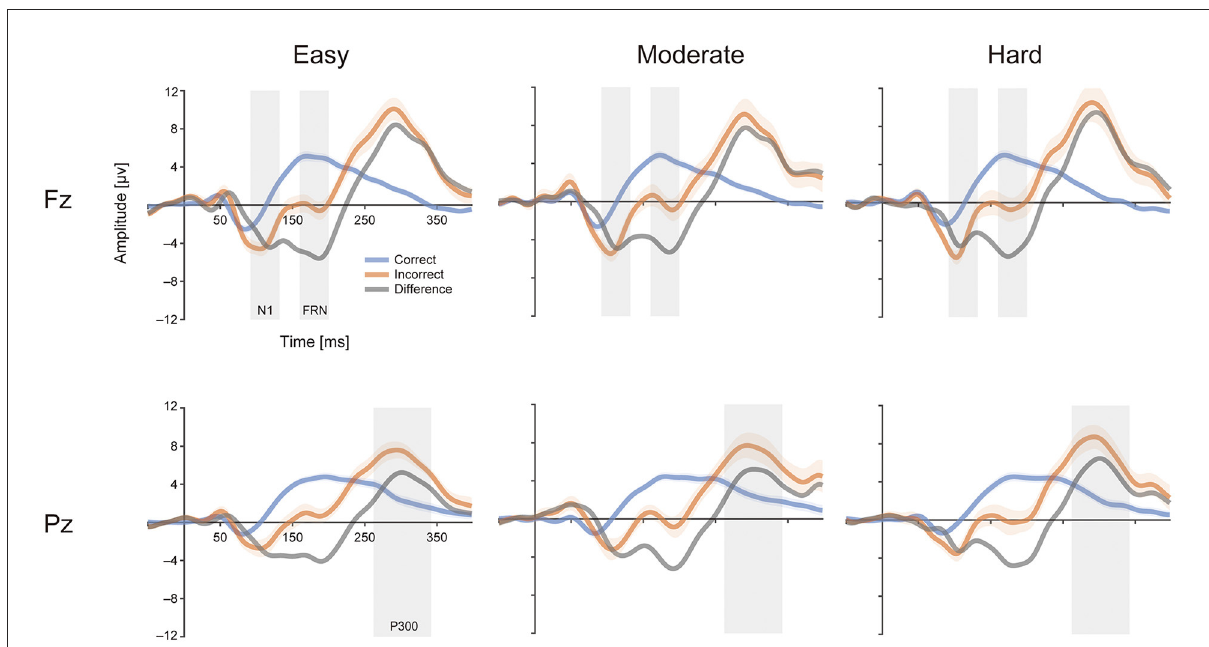
FIGURE7 The grand average event-related potentials (ERPs) for correct and incorrect trials time-locked to the feedback onset and their difference waveforms for each channel and level of goal score. The blue and red area represents the standard error for correct and incorrect trials, and the gray rectangles represent the range of the time window for calculating the mean amplitude of each ERP. For each level of goal score, participants with fewer than 12 incorrect trials were excluded from the calculation of ERPs for incorrect trials at that level of goal score in terms of signal-to-noise ratio.